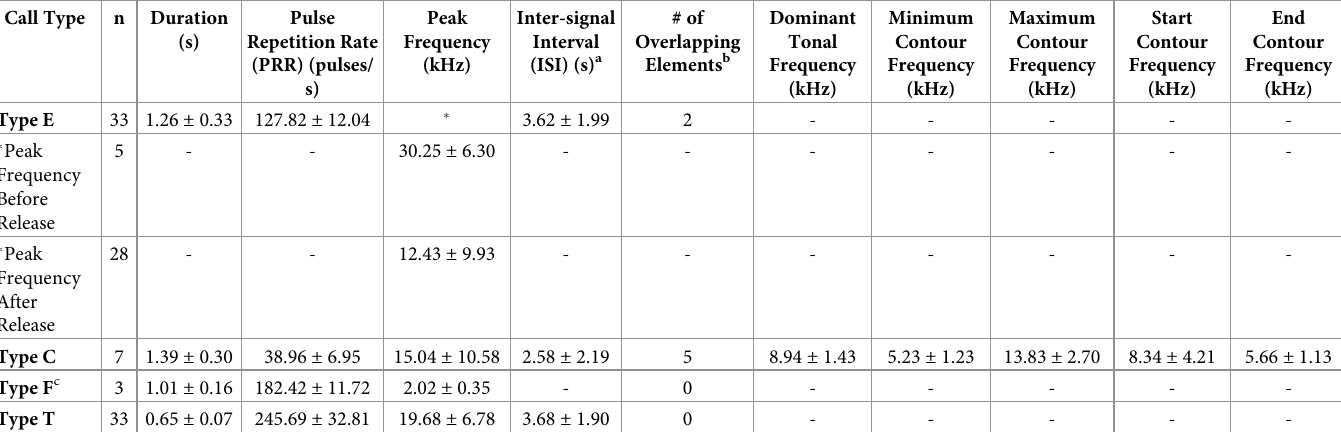
Table 1. Mean ± SD of parameters extracted from calls of type E (Eistla), C (calf), F (Freya), and T (Thora).